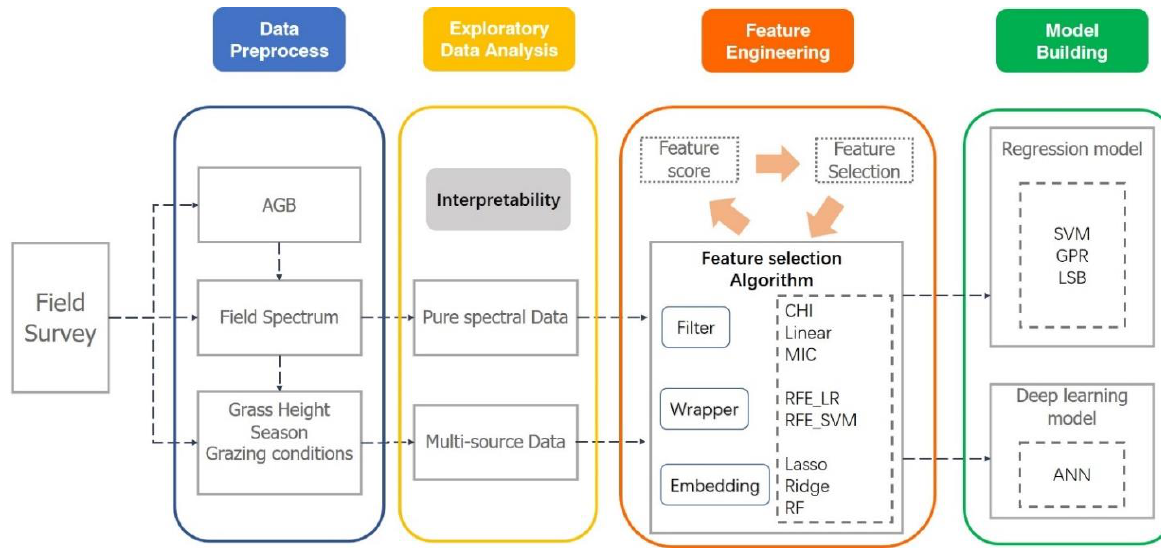
Figure 4. AGB inversion data processing course.